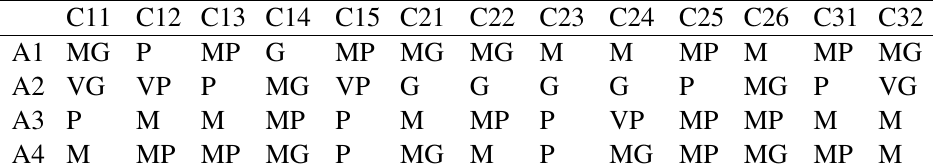
Table 5 Decision matrix according to linguistic